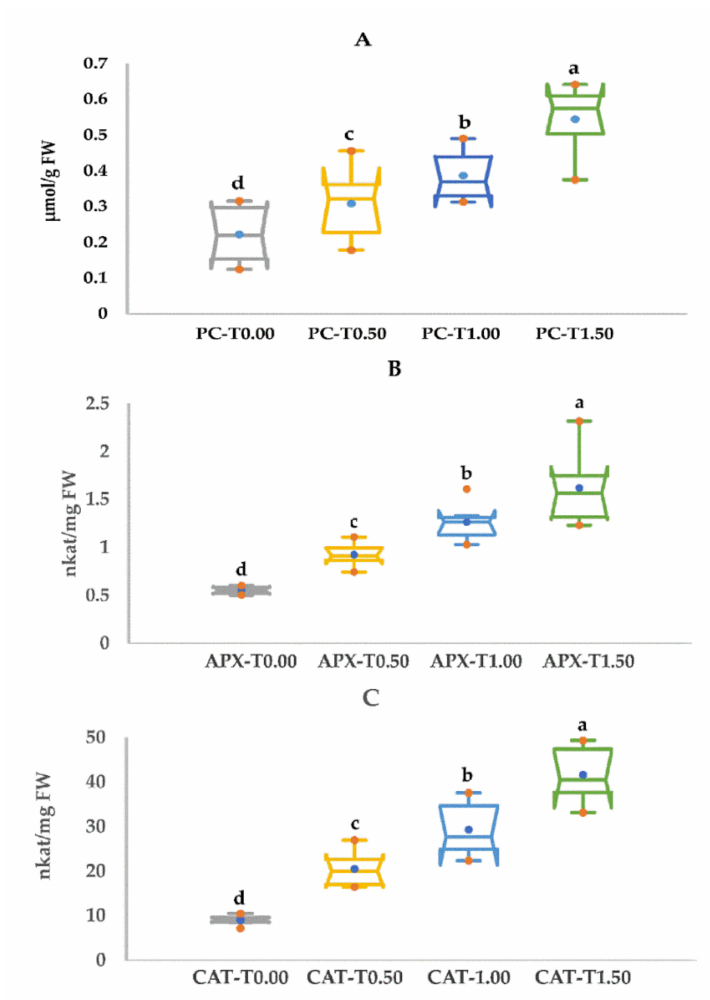
Figure 3. Box plots of biochemical traits of the kernel-derived calli from six rice genotypes, showing the significant variations between non-stressed and stressed conditions. ( A ). proline content (PC), ( B ). ascorbate peroxidase (APX), and ( C ). catalase (CAT). The numbers given are the mean values calculated for the six measurements obtained for control (T0.00), and PEG concentrations (T0.5, T1.00, and T1.50). Di ff erent letters suggest a significant variation between mean values by Duncan’s multiple-range analysis ( p ≤ 0.05). A blue dot in the box represents the mean value. Red dots denote the minimum and maximum values, while extreme values (outliers) are represented as dots outside the